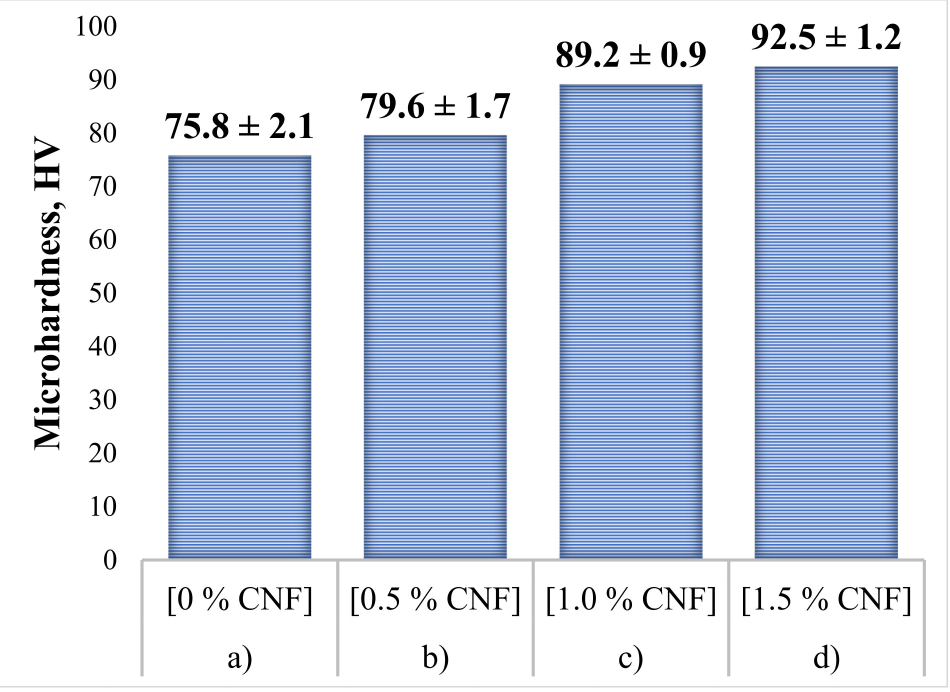
Figure 11. Microhardness of the synthesized samples: ( a ) 30% Al + 70% Al 2 O 3 ; ( b ) 29.5% Al + 70% Al 2 O 3 + 0.5% CNF; ( c ) 29% Al + 70% Al 2 O 3 + 1.0% CNF; ( d ) 28.5% Al + 70% Al 2 O 3 + 1.5%